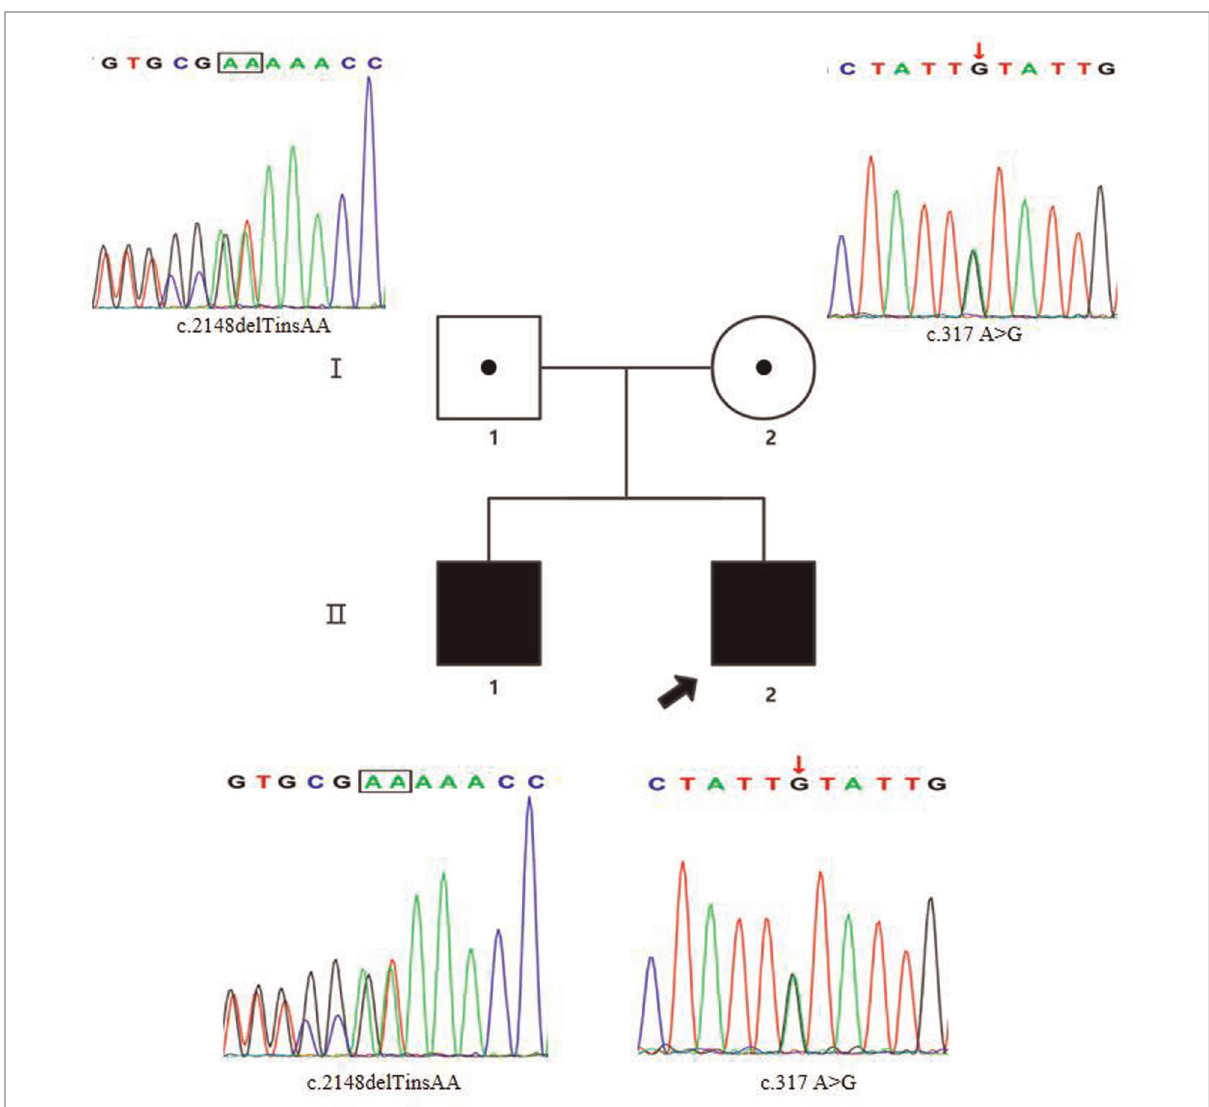
FIGURE 1 Pedigree chart and Sanger sequencing results of the family members. The proband was the younger brother (marked with the black arrow). The two siblings carried the compound heterozygous FIG4 variants. The results of Sanger sequencing indicated that the father was a heterozygous carrier of the c.2148delTinsAA (p.P718Tfs*3) variant (marked with the black box), and the mother was a heterozygous carrier of the c.317A>G (p.Y106C) variant (marked with the red